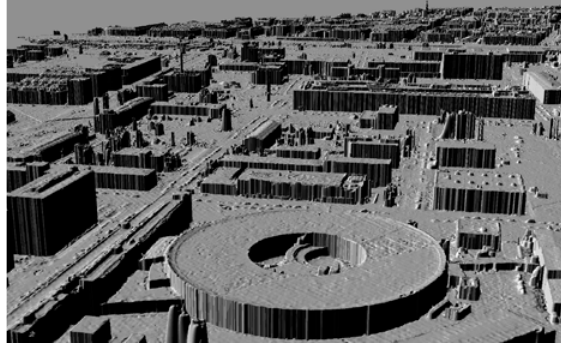
Figure 6: A detailed view of the corresponding part of the generated